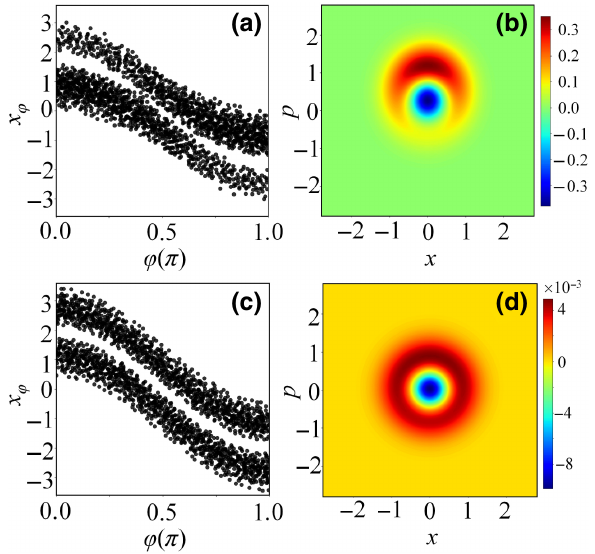
FIG. 16. Quantum tomography of optical “catlike” CSS [(a) and (b)] and “kittenlike” CSS [(c) and (d)] states created when the HHG and the QS are switched on. The left panels show the calculated homodyne detection signal x φ and the right panels the corresponding Wigner functions centered at | α | . The calculations are preformed using state | φ c (cid:2) = | α + χ (cid:2) − ξ ( IR ) | α (cid:2) (with | α | = 2) created by conditioning on the HHG process. The value of | χ | is set at 0.8 for the optical “catlike” state [(a) and (b)] and reduced to 0.1 for the “kittenlike” state [(c) and (d)].